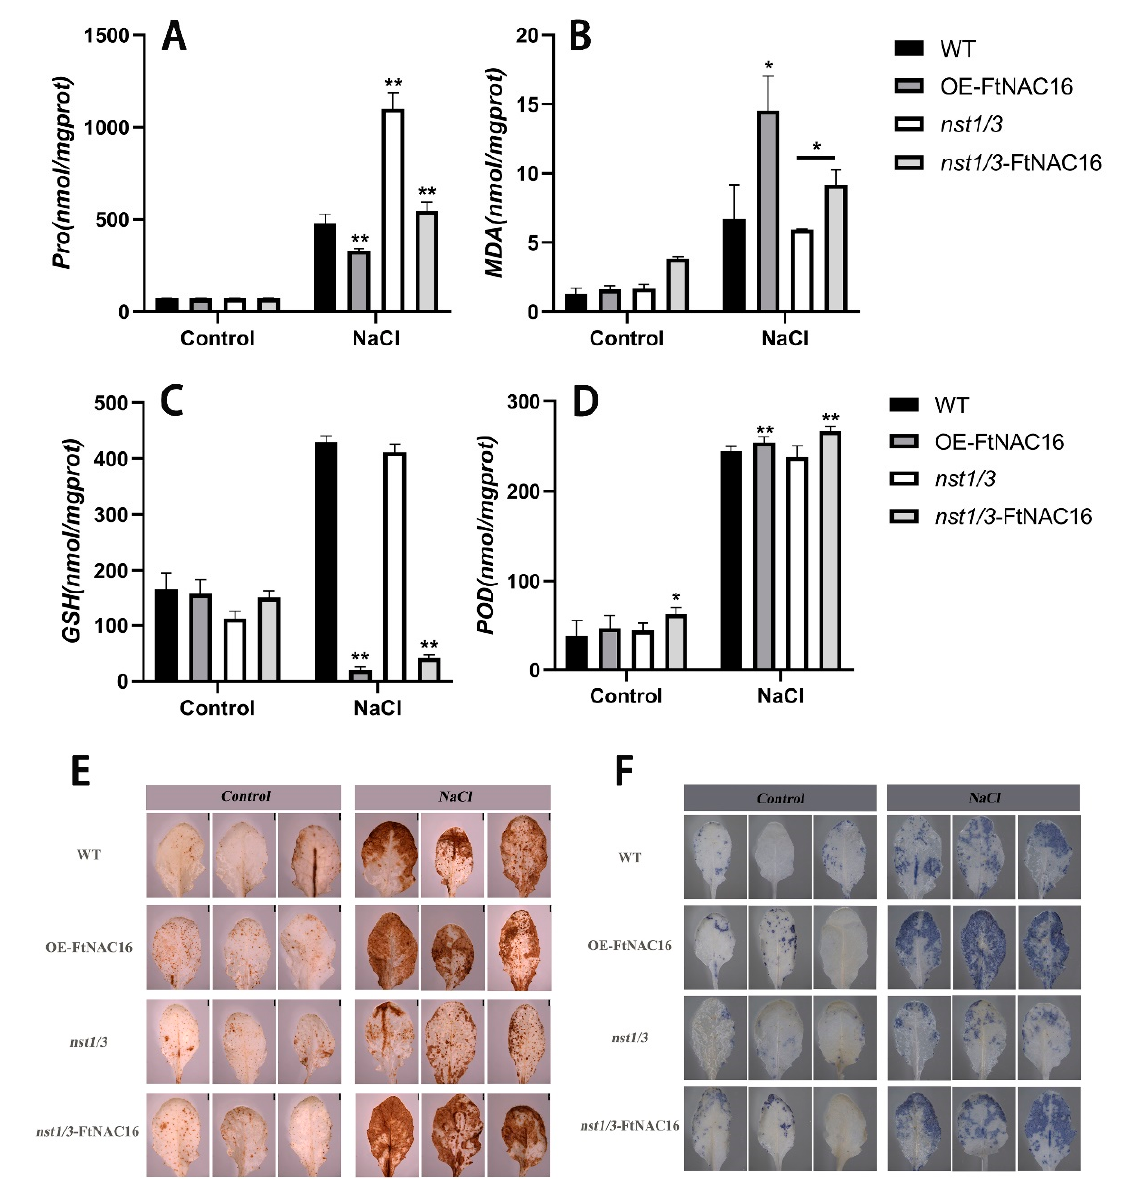
Figure 6. Effects of FtNAC16 on the physiological status of plants under salt stress. ( A ) The content of proline; ( B ) The content of MDA; ( C ) The content of GSH; ( D ) The content of POD; ( E ) The accumulation of H 2 O 2 in the leaves of WT and transgenic lines was analyzed by means of histochemical staining with DAB under normal conditions and abiotic stress conditions, respectively. ( F ) The accumulation of O 2 − in the leaves of WT and transgenic lines was analyzed by means of histochemical staining with NBT under normal conditions and abiotic stress conditions, respectively. The error bars denote ± SDs, and each data value is from three replicate experiments. At least 10 plants were used per experiment per line. * represents t -test significance: p < 0.05; ** represents t -test significance: p < 0.01.